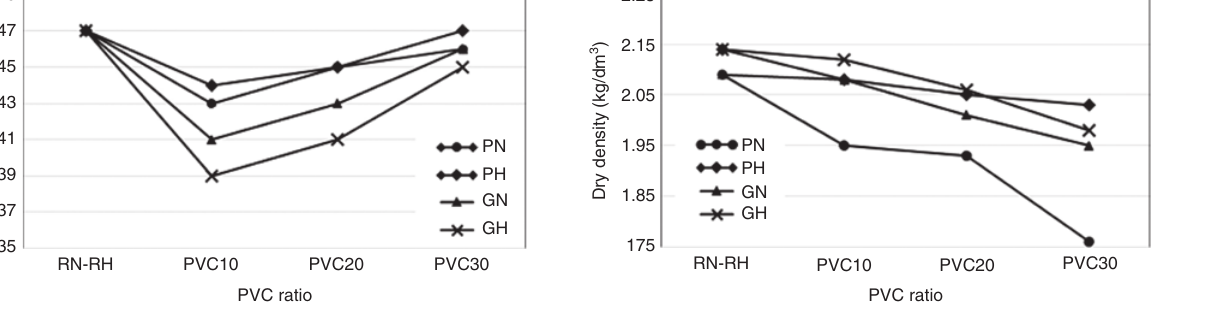
Figure 7 Dry density tests of polyvinyl chloride-containing